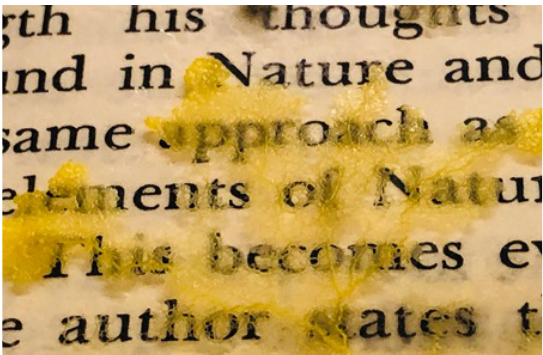
Figure 2 | Degenerative Cultures , in Sentient States , Portugal, Cesar & Lois, 2019. Detail of Physarum polycephalum’s growth over text of Jacques Boyceau and the French Formal